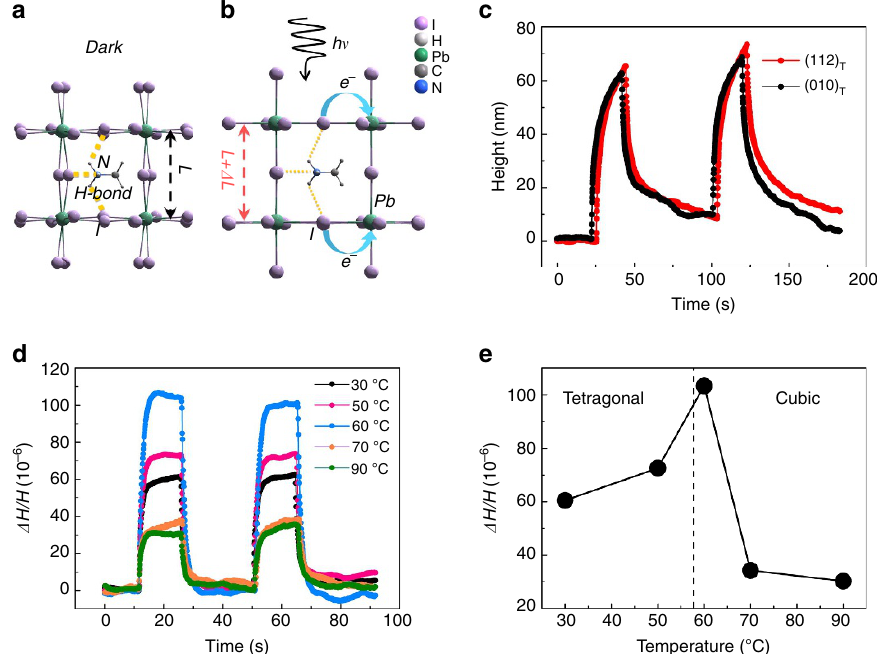
Figure 5 | Proposed mechansim for the giant photostriction in MAPbI 3 . ( a , b ) Schematic illustrations (not to scale) showing that the weakening of the hydrogen bonding between the amine group and the iodine ion by photo-generated carriers leads to the lattice expansion. ( c ) Orientation dependence of photostriction of a MAPbI 3 single crystal shows similar magntidue due to the isotropic expansion of the lattice. ( d , e ) Temperature-dependent photostriction of a MAPbI 3 single crystal across the tetragonal-cubic phase transition under 100mWcm (cid:3) 2 white light. The phase transition point is indicated by the black dash line. Enhanced lattice susceptibility around the phase transition boundary is likely responsible for the larger photostriction